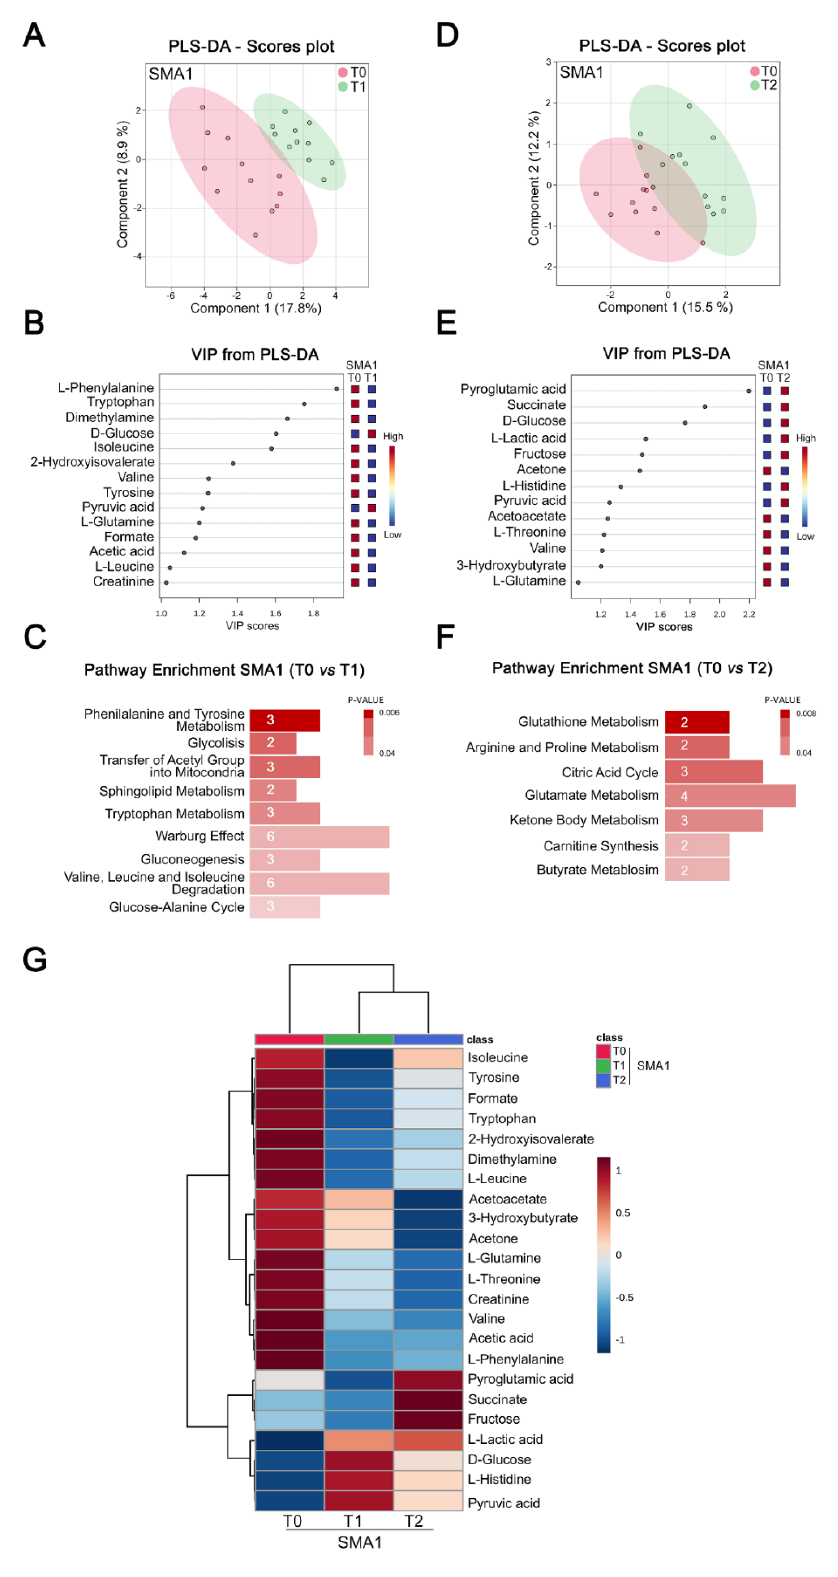
Figure 3. Nusinersen modulates amino acid and glucose metabolism in the CSF of SMA1 patients. ( A , D ) PLS-DA score scatter plots showing the metabolomic profiles of CSF for SMA1 patients prior to treatment (T0) and at loading (T1) ( A ) or maintenance (T2) phases ( D ) of Nusinersen administration. PLS-DA was evaluated using cross validation (CV) analysis. The clusters analyses are reported in the Cartesian space that is described by the main components, PC1: 17.8% and PC2: 8.9%